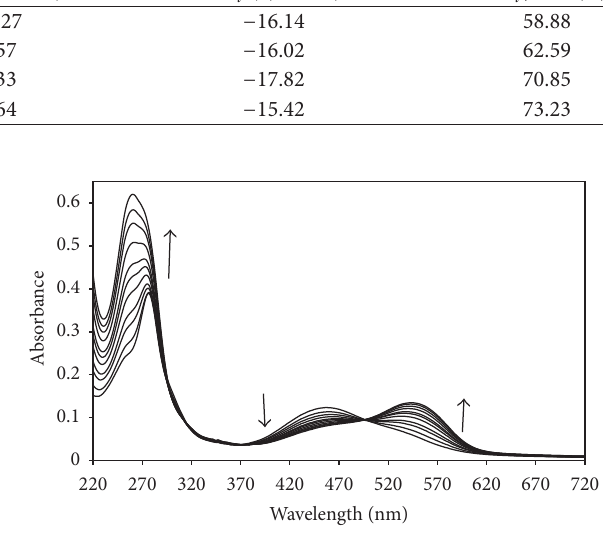
, and ). 0 0 𝑝𝑝𝑝𝑝 Δ𝐺𝐺 Δ𝐺𝐺 Δ𝐺𝐺